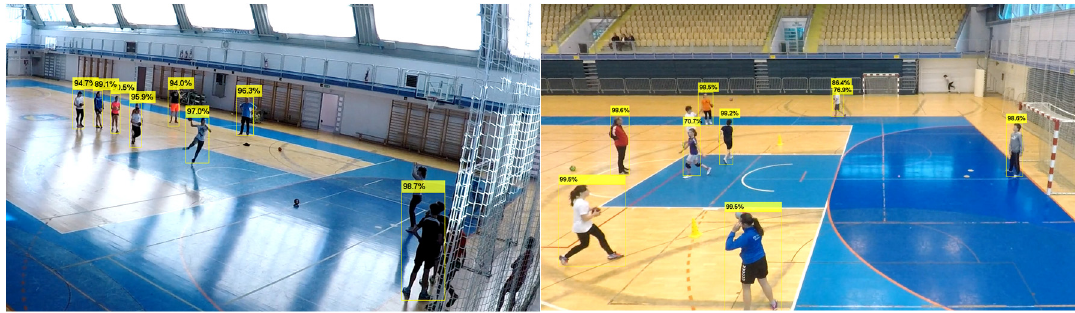
Figure 3. Bounding boxes with confidence values as results of person detection with YOLOv3.